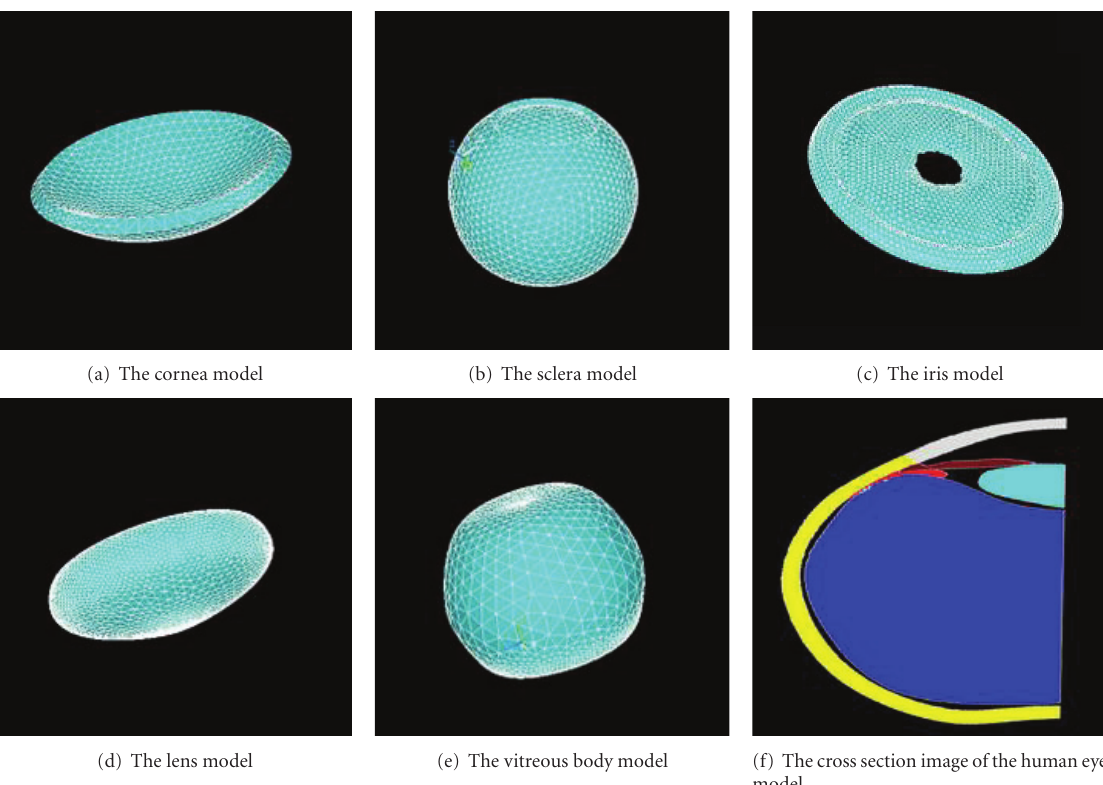
Figure 8: Human eye tissue models constructed through slice images.